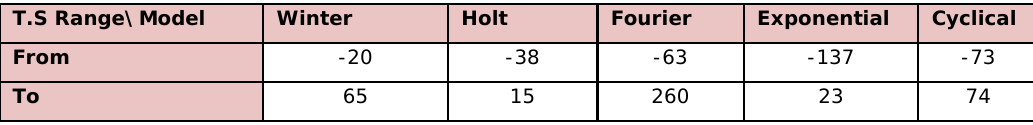
Table 10. “Tracking signal range”